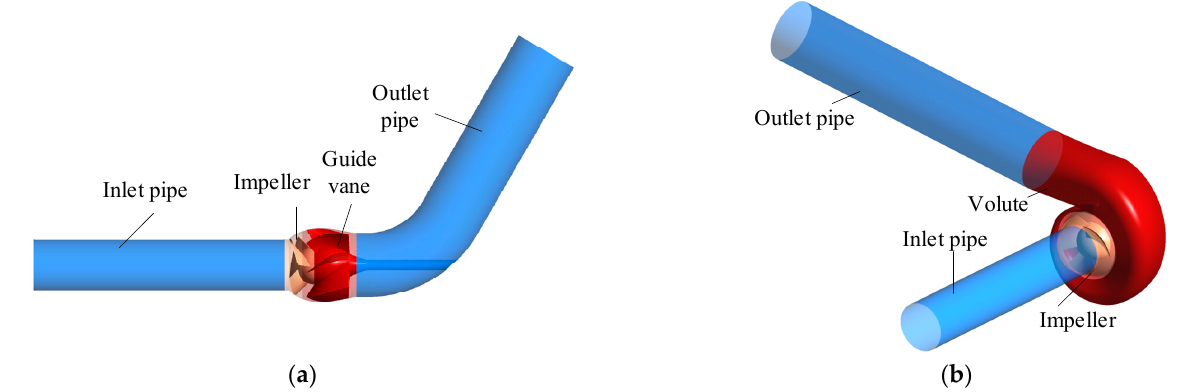
Figure 1. A 3D schematic diagram of ( a ) mixed-flow pump with guide vanes and ( b ) mixed-flow pump with a volute.